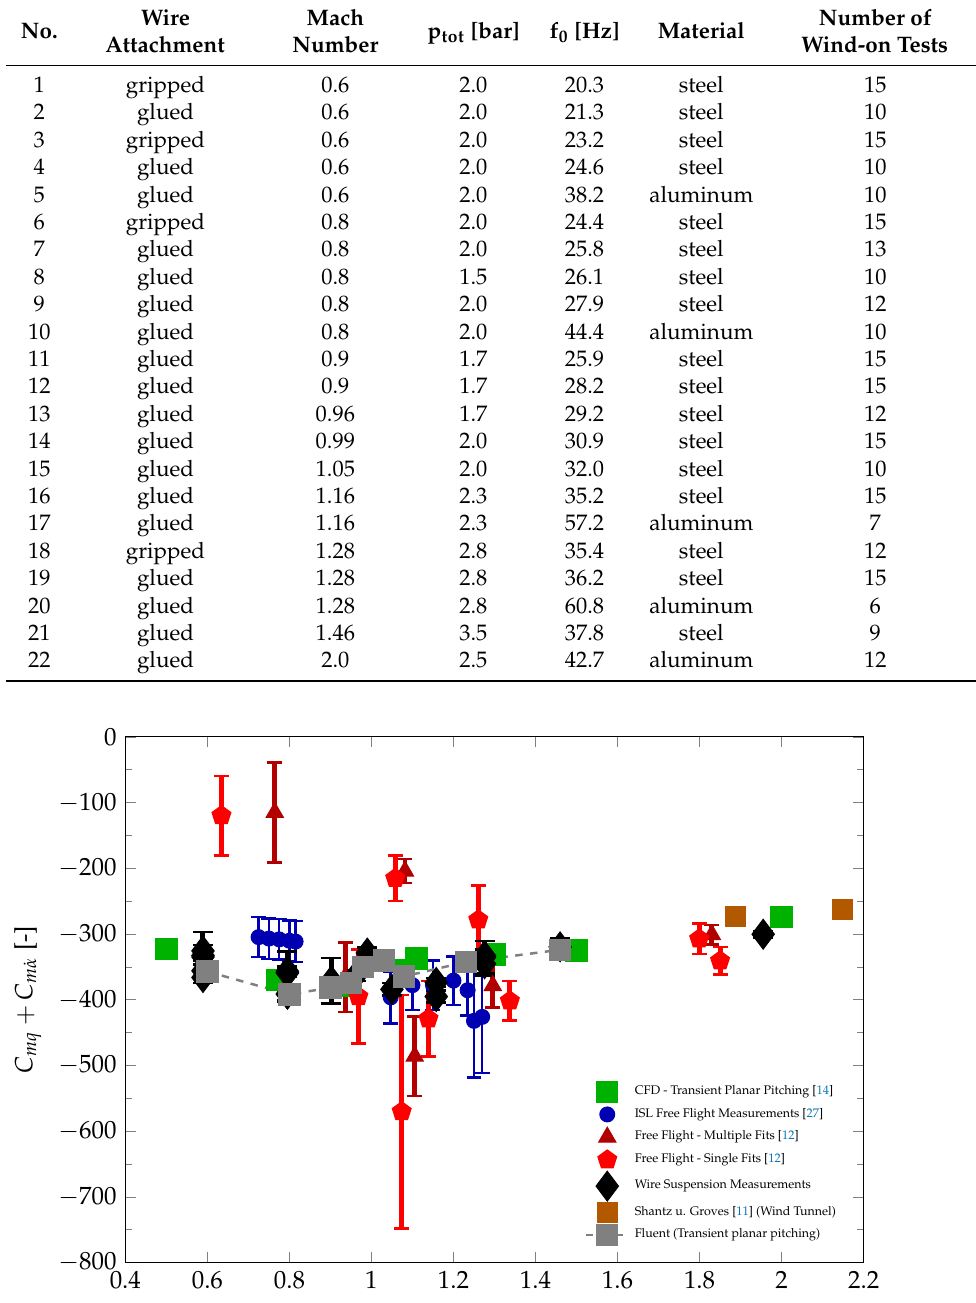
Table 1. Test case conditions for the Basic Finner model.